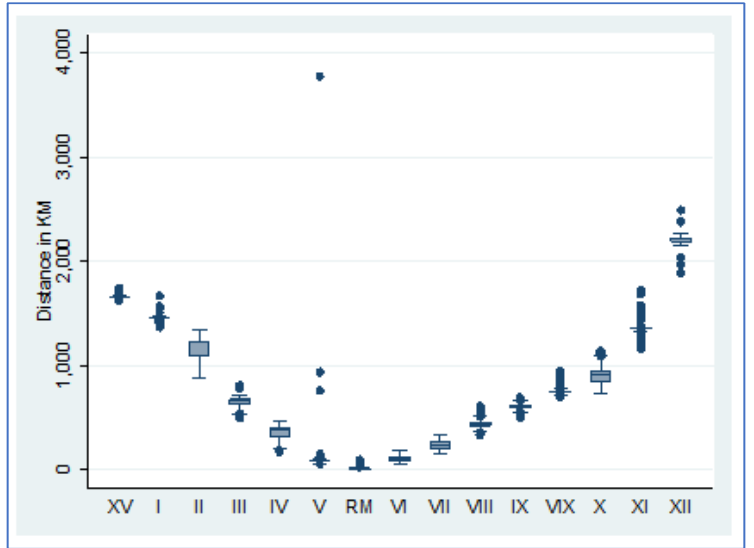
Figure 2. Distance to Santiago distributions after the georeferencing process. The boxplots represent the distribution of distances from each candidate’s home to the city of Santiago. There is one boxplot for each Chilean region. The horizontal axis plots the Chilean regions in Roman numerals. XV represents Arica and Parinacota, I represents Tarapac á , II represents Antofagasta, III represents Atacama, IV represents Coquimbo, V represents Valpara í so, RM represents Metropolitan Region of Santiago, VI represents O’Higgins, VII represents Maule, VIII represents B í o-B í o, IX represents Araucan í a, XIV represents Los R í os, X represents Los Lagos, XI represents Ays é n, and XII represents Magallanes. The figure shows only a few outliers in the V region (Valpara í so). These outliers are accurate, as they correspond to some of the Pacific islands that fall under the Valpara í so Region’s